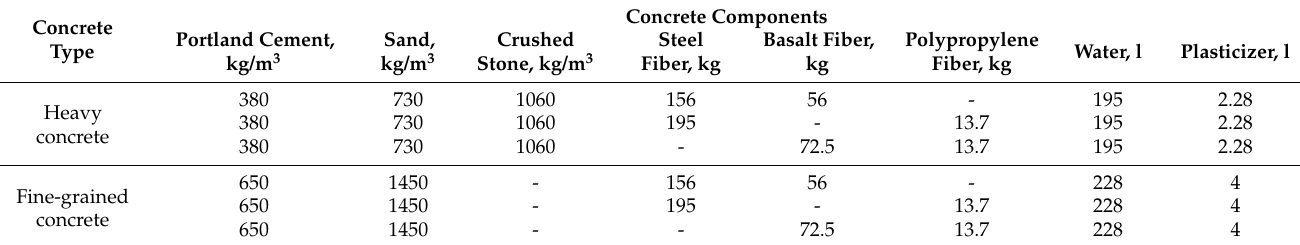
Table 11. Variants of compositions of various types of fiber-reinforced